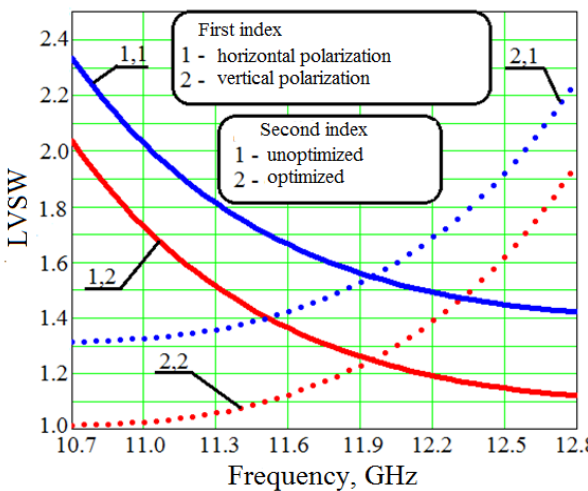
FIGURE 2. Dependences of LVSW on frequency for a square waveguide polarization converter with three diaphragms